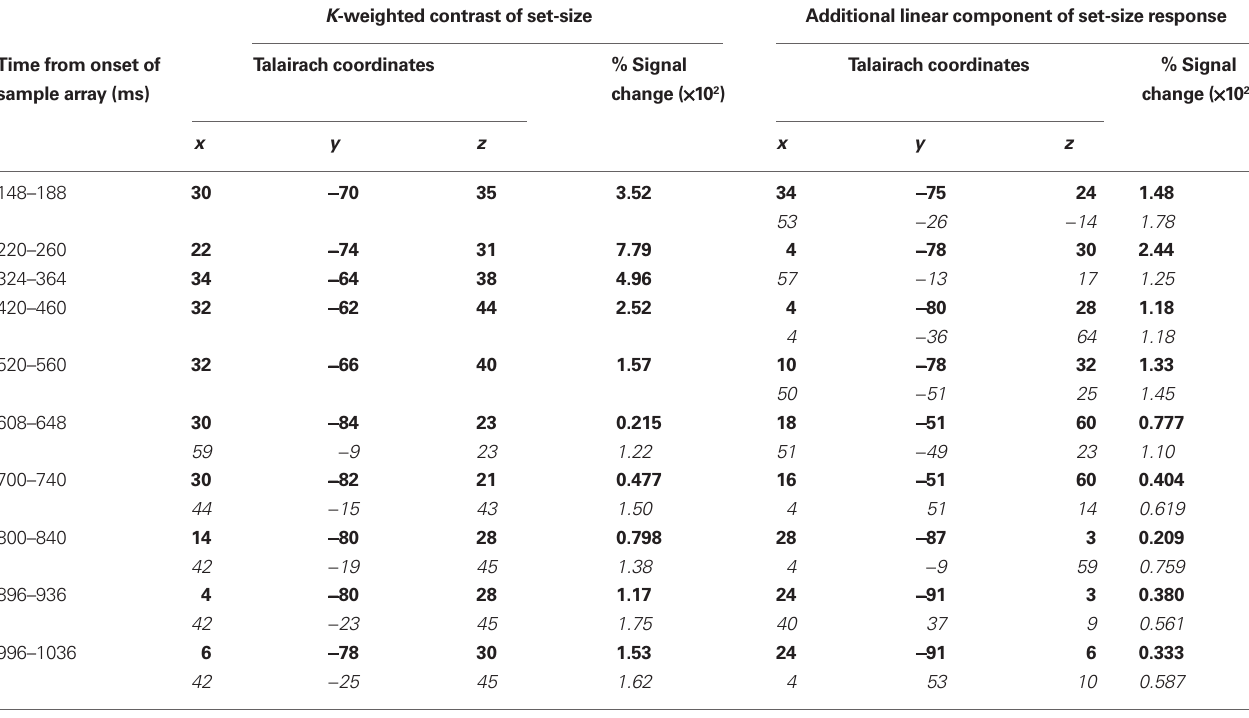
Table 1 | Peak coordinates of source-localized bilateral load effects. K -weighted contrast of set-size Additional linear component of set-size